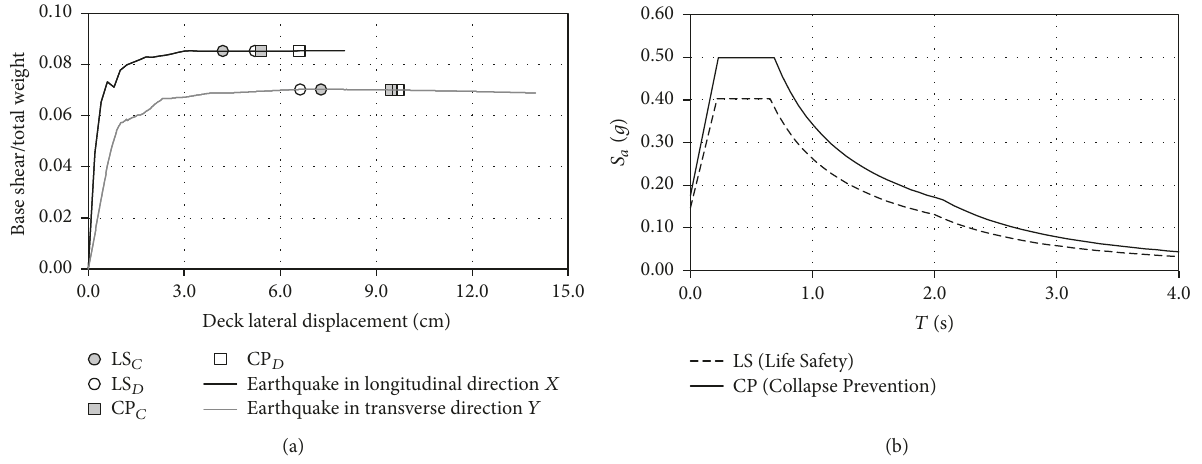
Figure 7: (a) Capacity curves of the existing bridge. (b) Elastic demand response spectra, in terms of acceleration for the LS and CP Limit States defined for the site considered.